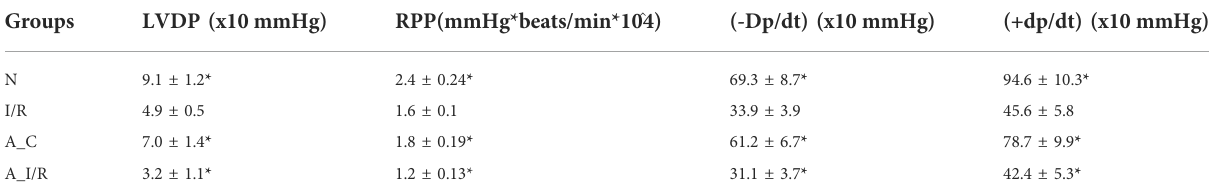
TABLE 1 Impact of I/R on cardiac hemodynamic indices in young and adult rat hearts: The impact of I/R was evaluated by the hemodynamic changes LVDP (leftventriculardiastolic pressure); RPP (RatePressureProduct= heartrate× LVDP)and±dp/dt(maximum/minimum force ofcontraction). The data are represented as mean ± SEM. *p < 0.05 vs. I/R . Groups